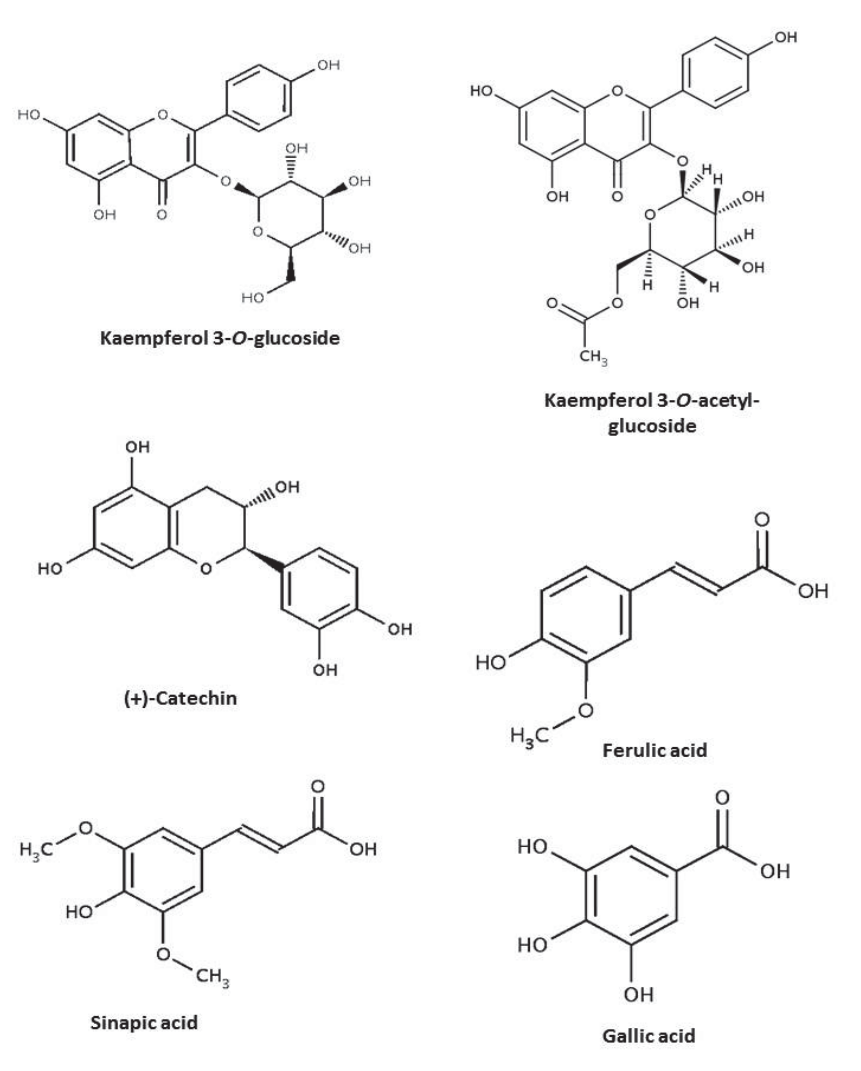
Figure 4. Structure of pinto based phenols (from ChEBI database